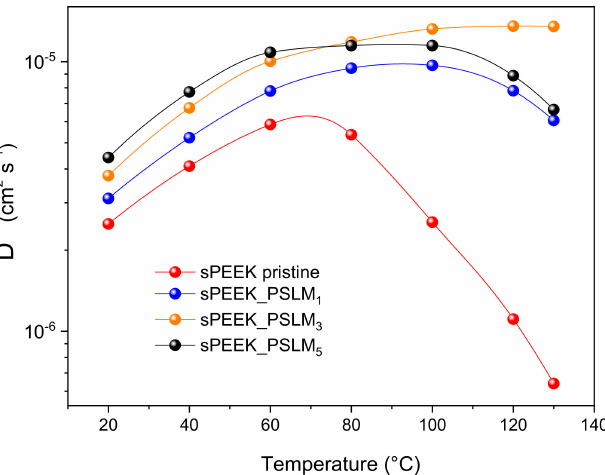
Figure 5. Self-diffusion coefficients (D) as a function of the temperature (from 20 ◦ C to 130 ◦ C) of the water confined in sPEEK-based